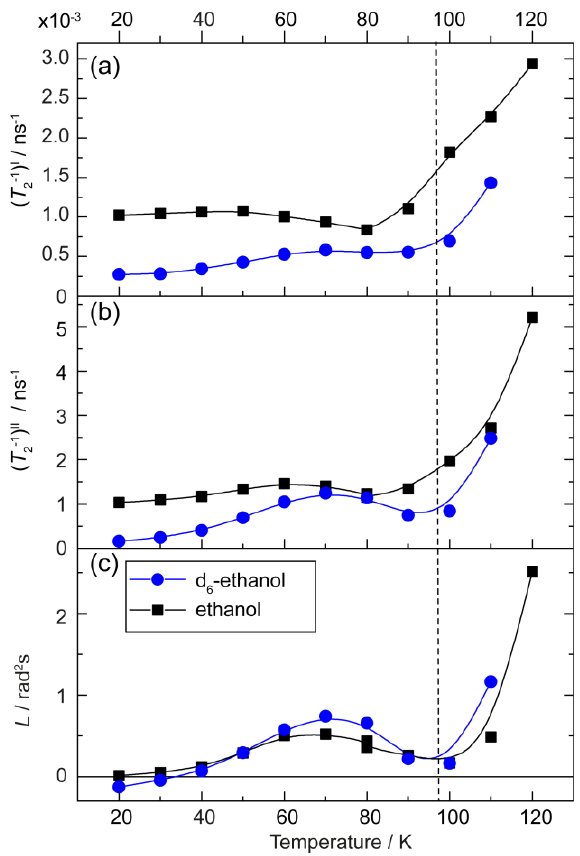
Figure 3. Temperature dependence of T 2 −1 recorded in spectral positions I (a) and II (b) of N1 for protonated and deuterated ethanol. (c) Temperature dependence of the motional parameter L for nitroxide radical N1 in protonated and deuterated ethanol. The vertical dashed line shows the glass transition temperature for ethanol T g = 97 K.